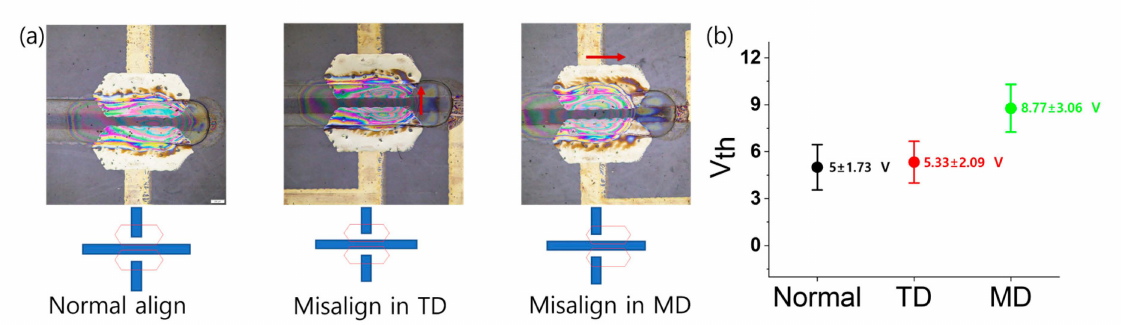
Figure 4. Effects of the OPRA on the variation in threshold voltage (V th ) of the R2R printed TFTs: ( a ) optical image of TFTs showing OPRA with normal alignment, misalignment in TD and misalign- ment in MD; and ( b ) Vth mean value variation for TFTs with normal alignment, misalignment in TD and misalignment in MD.